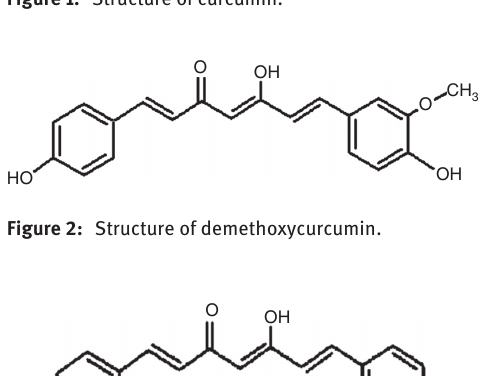
Figure 1: Structure of curcumin.